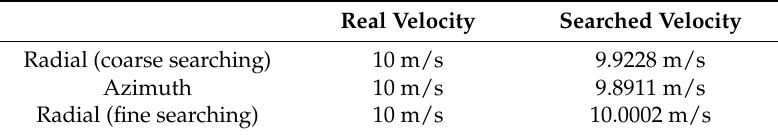
Figure 12. GRFT responses and azimuth profiles to different fine-searched radial velocities. Table 4. The parameters of the moving ship target.